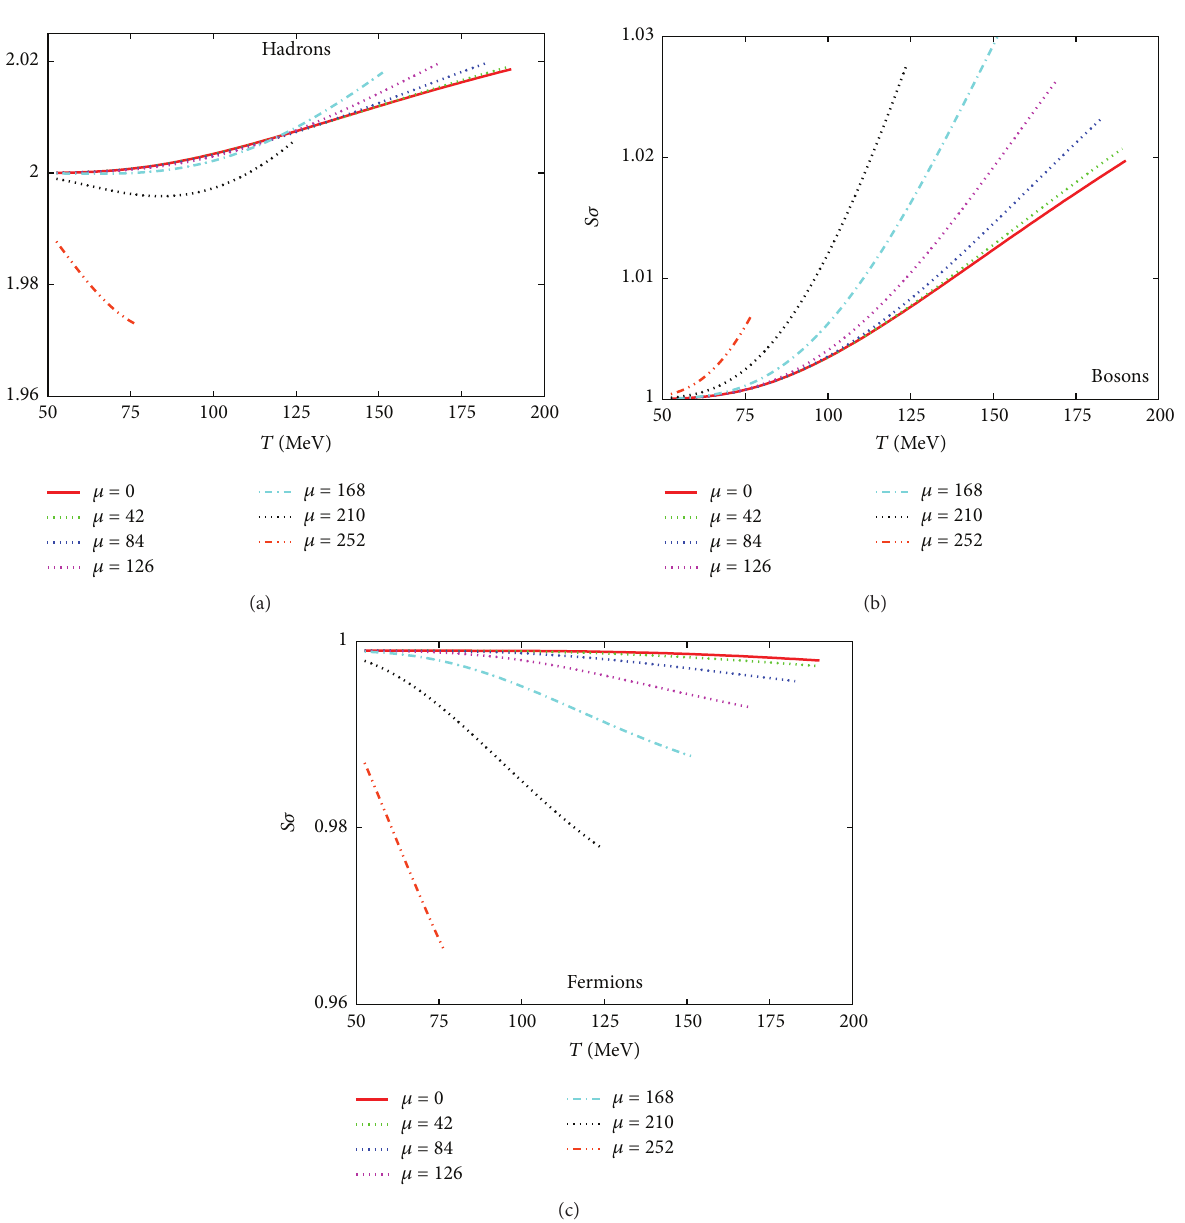
Figure 6: The product 𝑆𝜎 is given depending on 𝑇 at different 𝜇 𝑏 values (given in